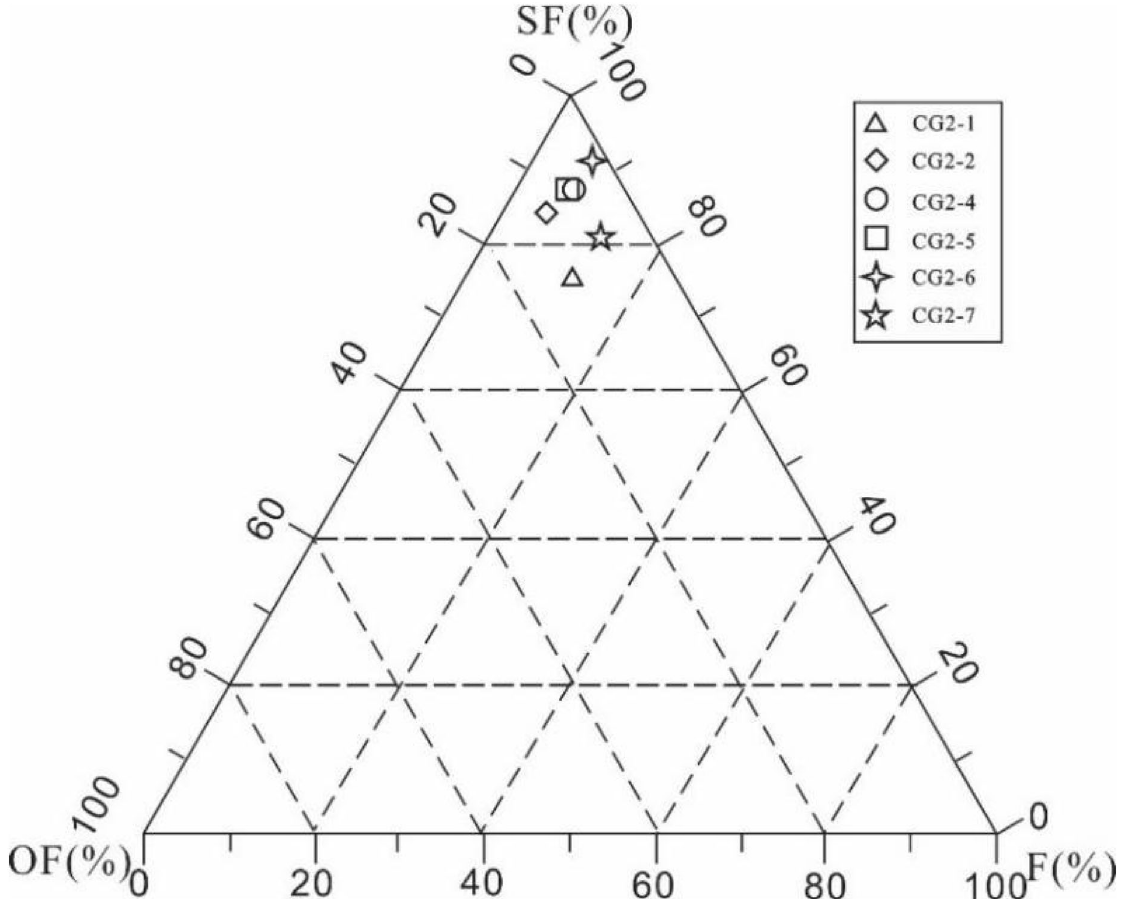
Fig. 4 The triangular diagram of F–OF–SF series of the